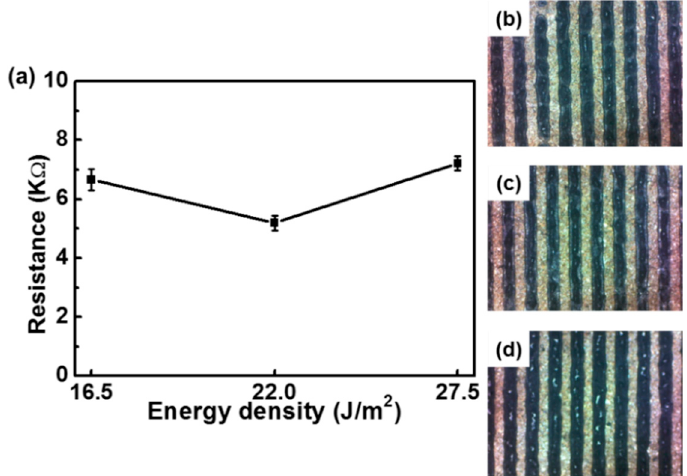
Figure 8. The patterned TiO 2 -rGO sheet resistance and optical image according to pulsed energy 5.5 J/cm 2 at one time. Sheet resistance ( a ), optical images of 16.5 J/m 2 ( b ), 22.0 J/m 2 ( c ), and 27.5 J/m 2 ( d ).